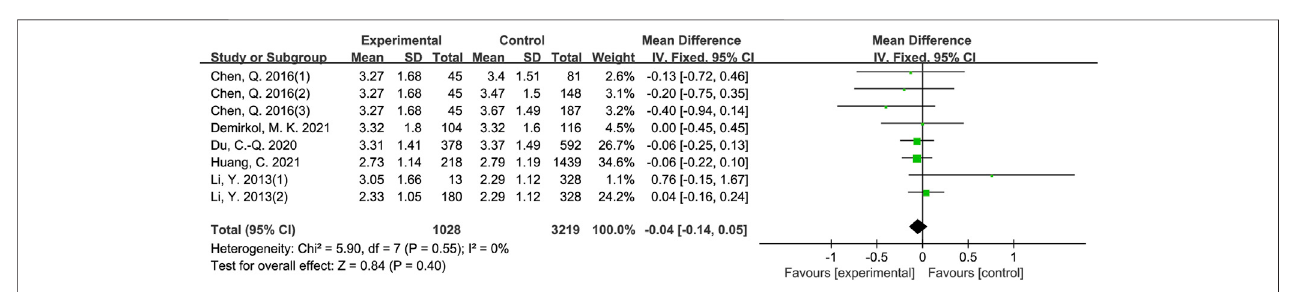
Frontiers in Physiology |